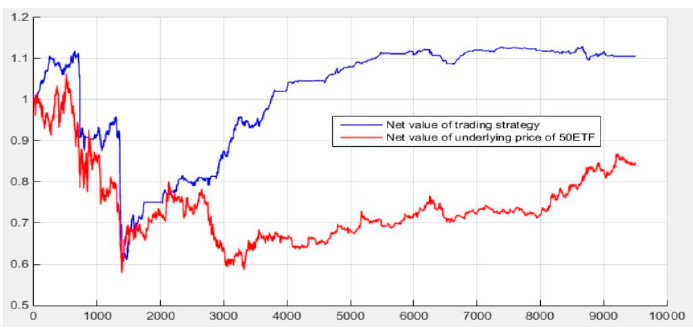
Figure 30. Daily trading frequency of 16 times (15 min).